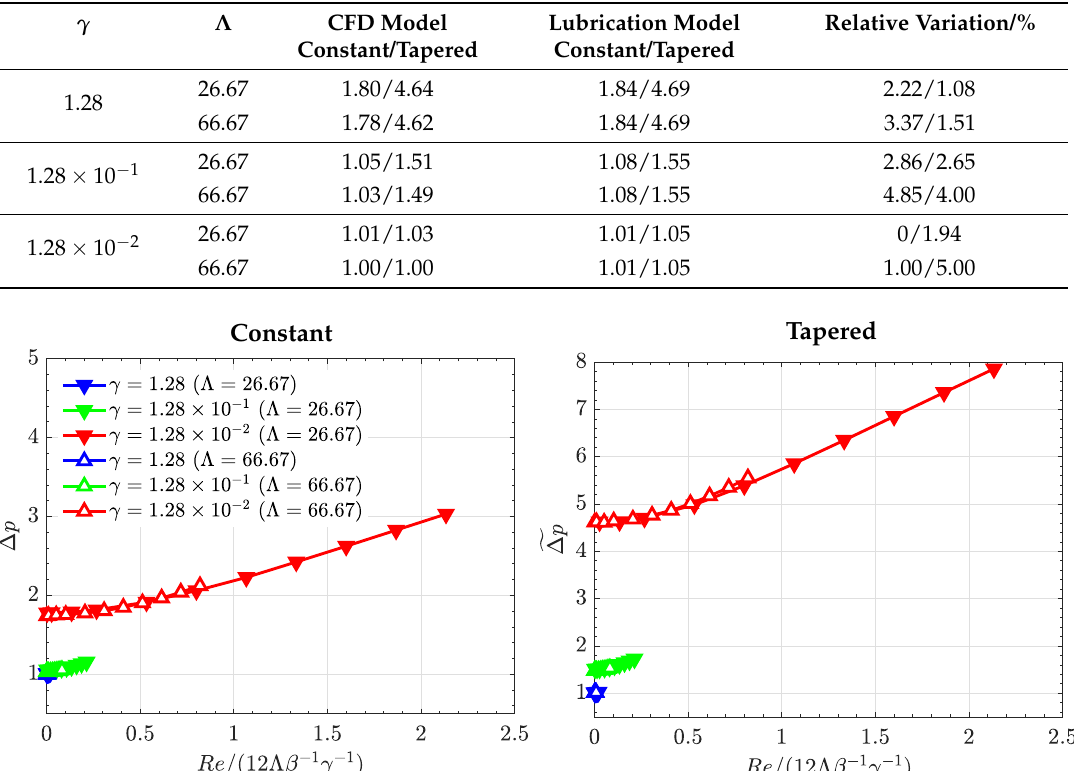
Figure 10. Variation of the overall pressure drop, (cid:102) ∆ p , as a function of Re / ( 12 Λ β − 1 γ − 1 ) computed with the CFD model for different values of γ and Λ , corresponding to the constant cross-section and tapered flow fields. Tapered channels with φ = 10 − 2 were considered to introduce a sharp corner similar to that used in the lubrication